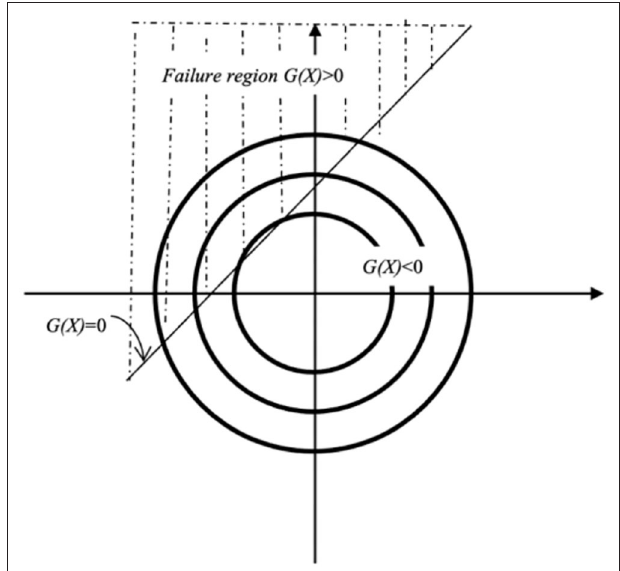
FIGURE 3 | Performance space for linear safety